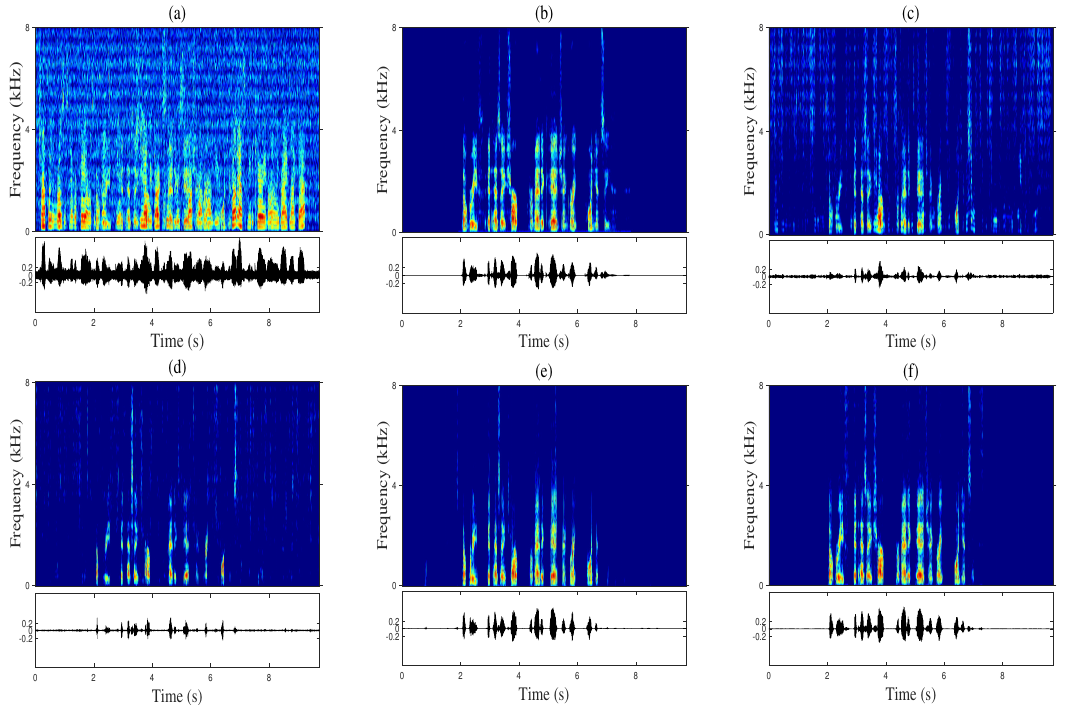
Figure 7. Spectrogram (top) and waveform (bottom) comparison under white noise and speech-type at the far-end (at a signal-to-echo ratio (SER) of -4 dB and an SNR of 3 dB): ( a ) microphone input signal, ( b ) near-end speech, ( c ) stacked DNN [11], ( d ) CRN [12], ( e ) single-channel version of Multi-TALK, and ( f ) the proposed Multi-TALK (4 ch).